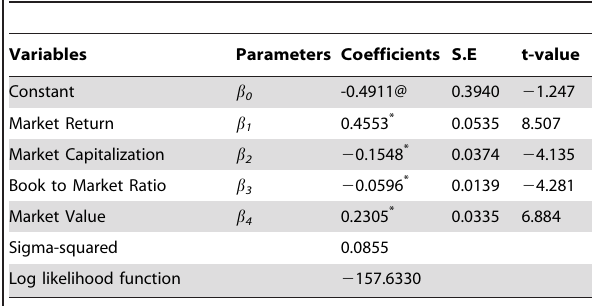
Table 1. OLS Estimates of the Cobb-Douglas Stochastic Frontier Production